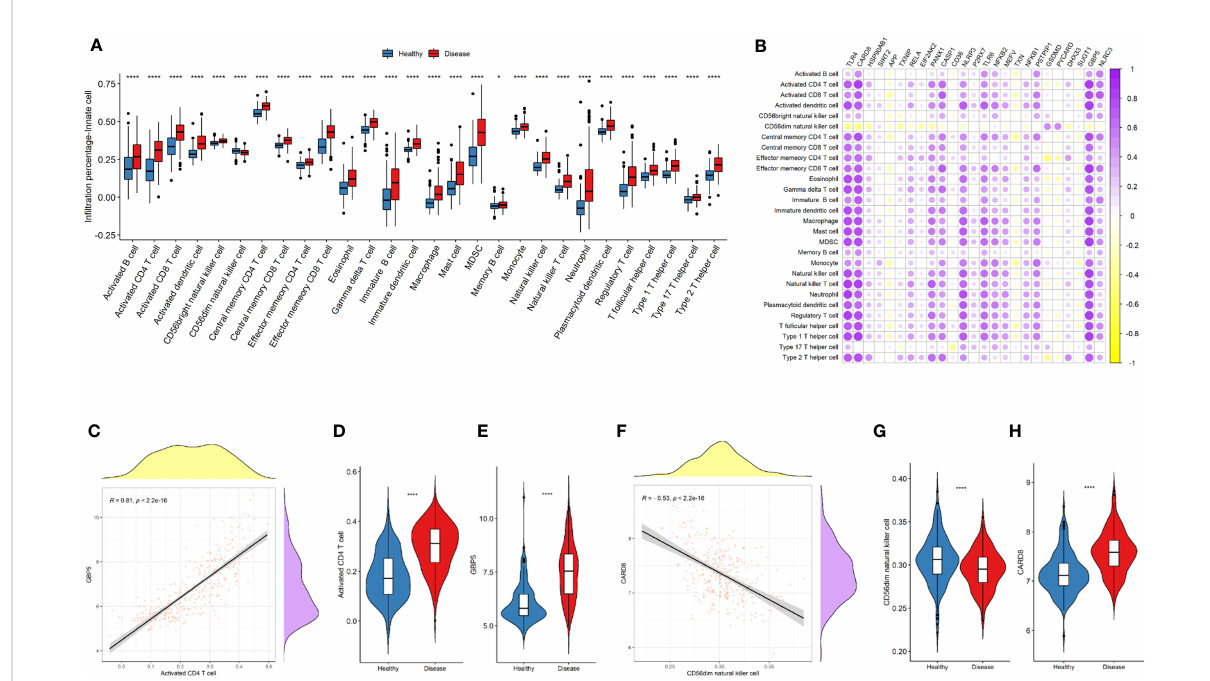
FIGURE 5 NLRP3 in fl ammasome-related genes and immune cell in fi ltrations in the immune landscape. (A) Comparison of immune cell in fi ltration levels between the two groups. (B) Correlation plot showing signi fi cant correlations between the genes and immune cell in fi ltrations. Purple: positive correlation. Yellow: negative correlation. Circles with deeper colors indicate stronger correlations. (C) Correlation between GBP5 expression and activated CD4 + T cell in fi ltration. (D, E) Violin plots showing the levels of activated CD4 + T cell (D) and GBP5 expression (E) in two groups. (F) Correlation between CARD8 expression and CD56dim natural killer cell in fi ltration. (G, H) Violin plots showing the levels of CD56dim natural killer cell (G) and CARD8 expression (H) in two groups. R represents Pearson correlation coef fi cients. *: P < 0.05; **** P ≤